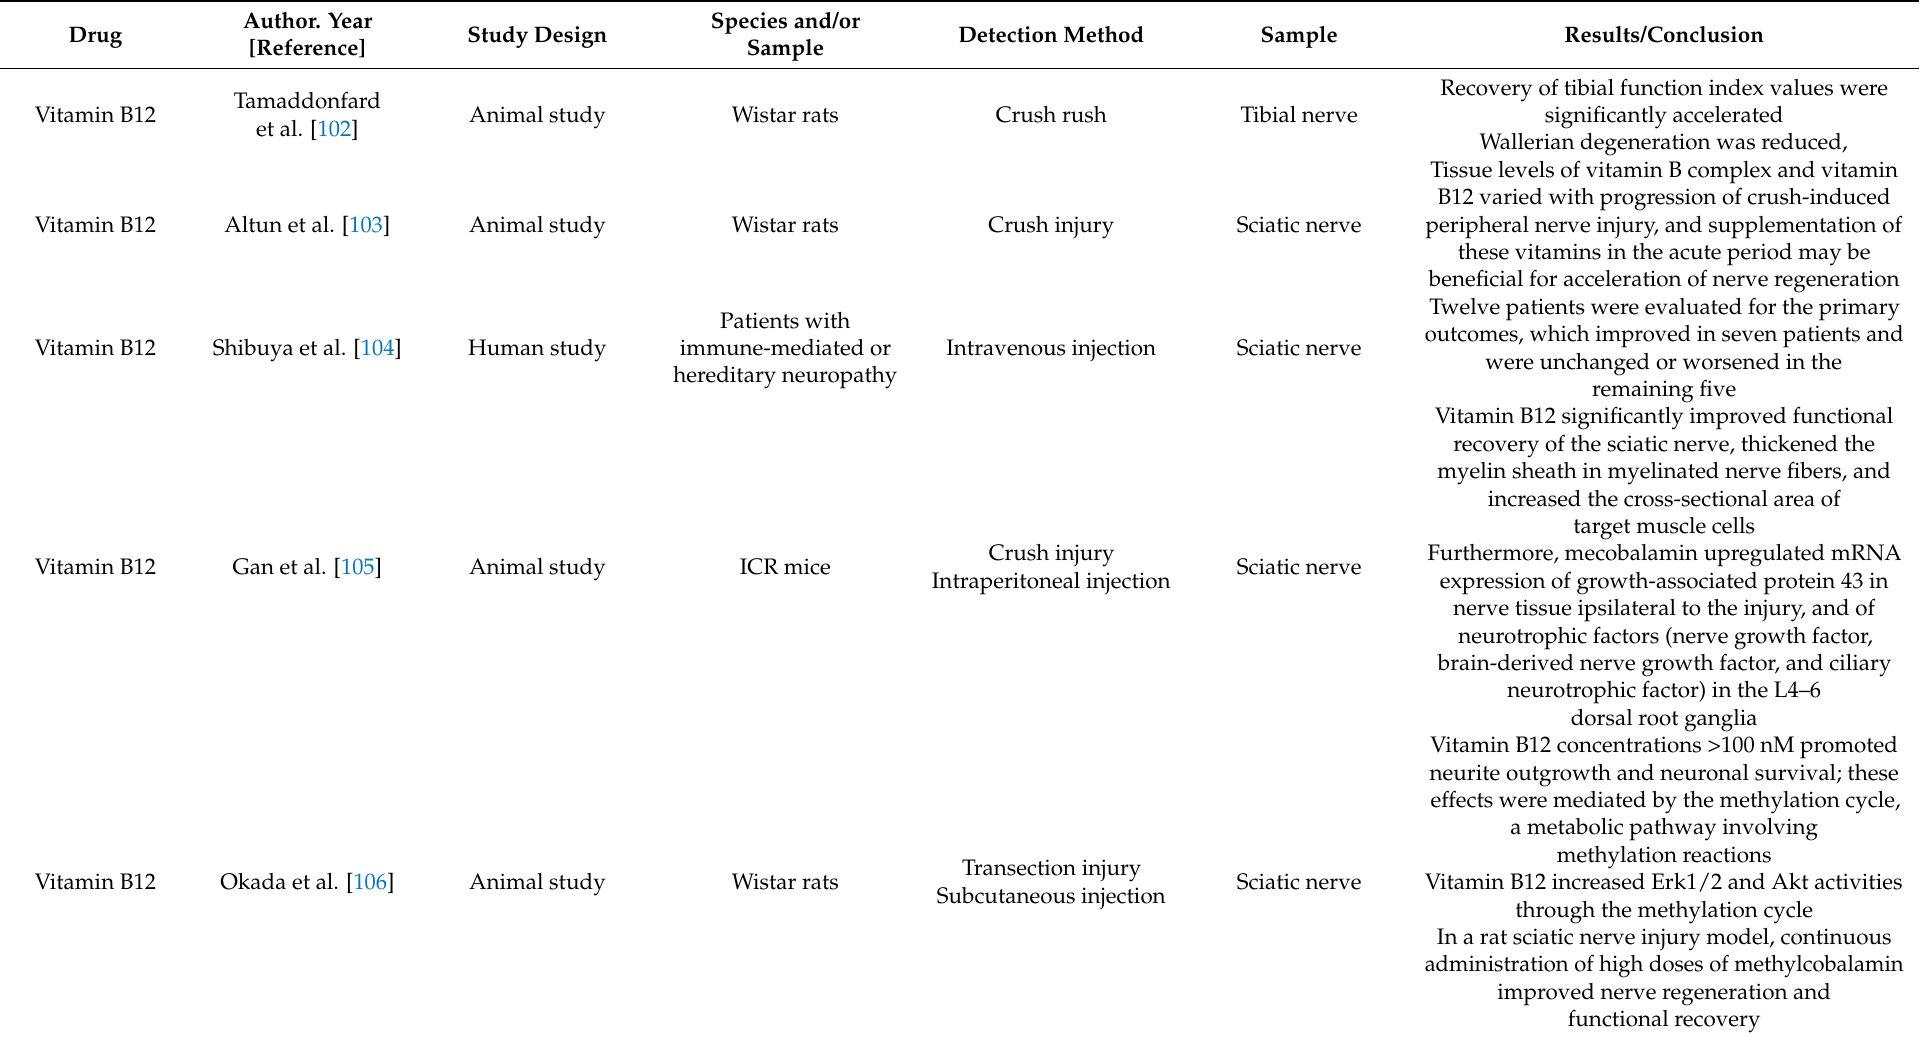
Table 7. Summary of studies that assessed vitamin B12 for the treatment of peripheral nerve